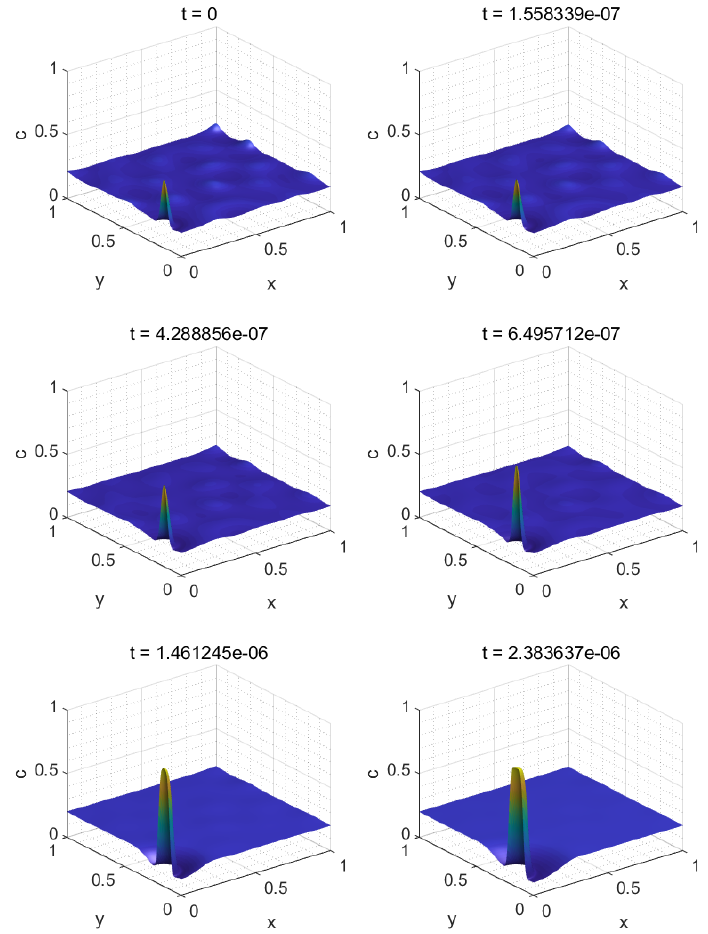
Figure 5. Dimensionless concentration spatial profiles c * ( x * , y * ) formed during the phase separation phenomena for the case where D = 10 5 , c o * = 0.2 and T * = 0.29. The asterisks were left out of the variables x , y , c , and t in the figure.